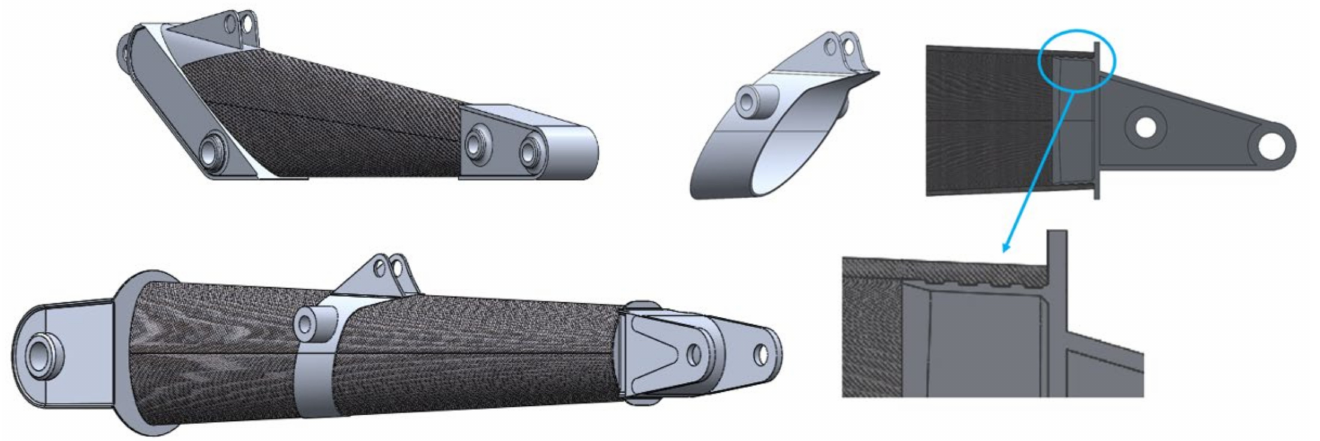
Figure 7. Geometrical solution for both the arms. The composite material is shown in dark grey; whereas, central and terminal elements made in the aluminium alloy are shown in light grey.